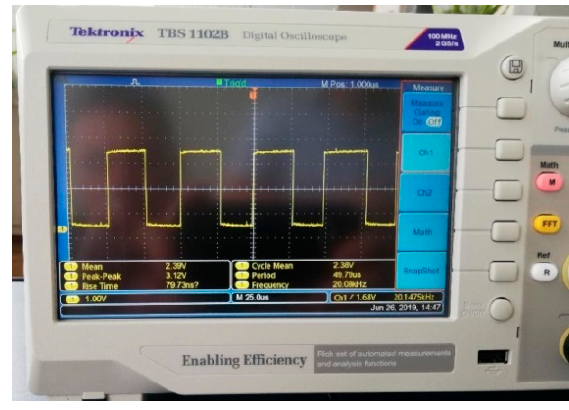
Figure 34. PWM signal waveform.